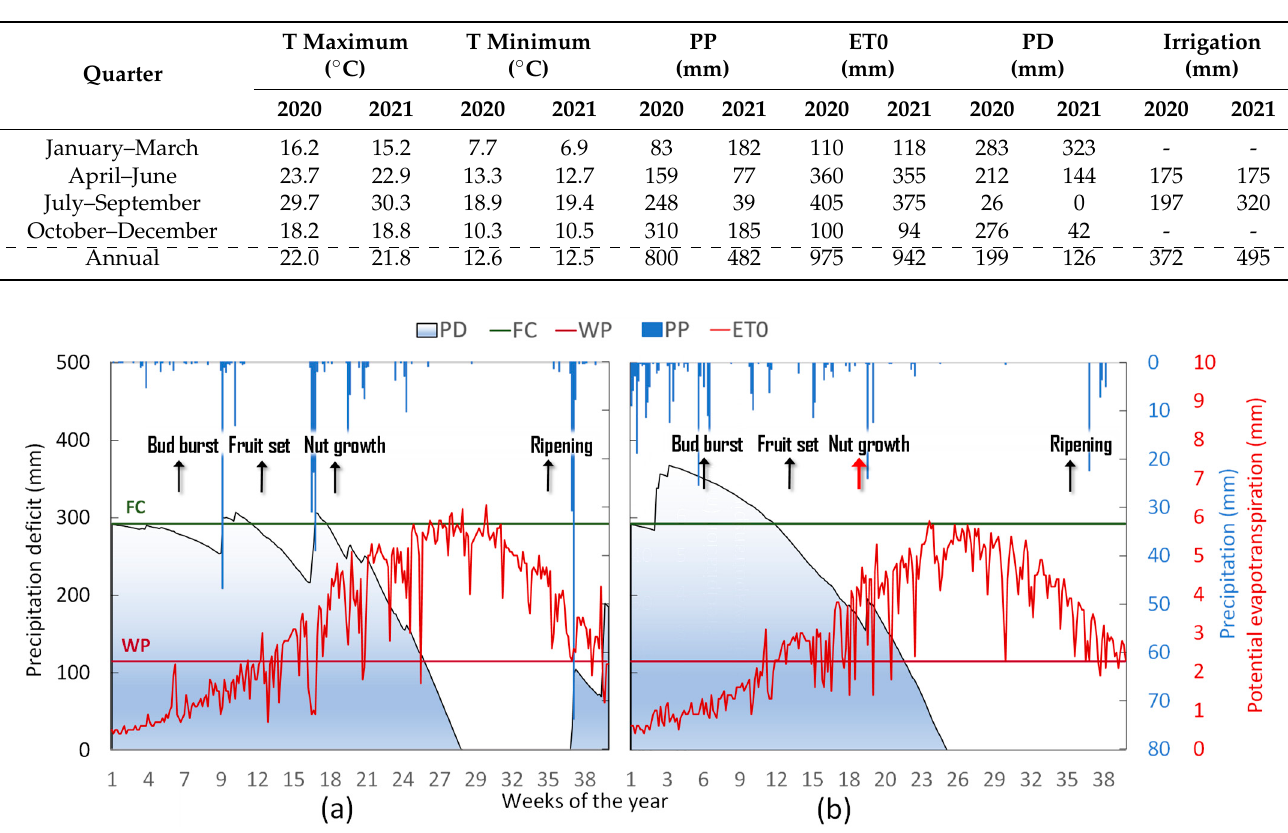
Table 2. Average meteorological conditions and irrigation supply during the study seasons.